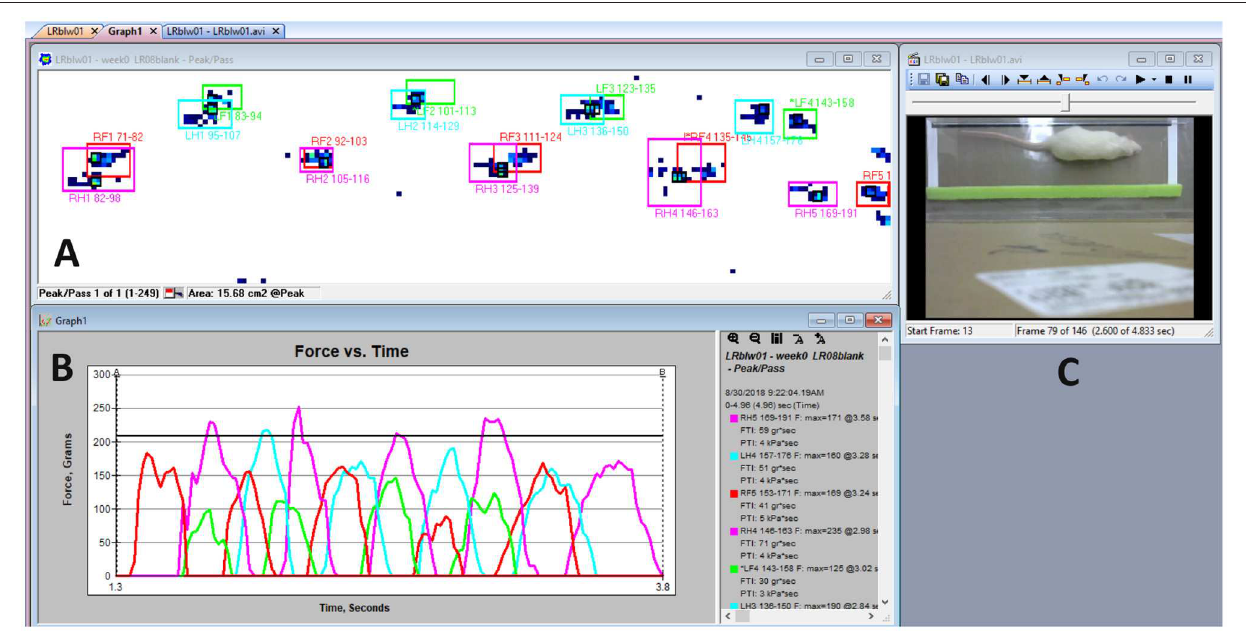
FIGURE 2 | Tekscan software display. (A) Example gait force profile during the subjects walk from right to left. Visual display of right forelimb (red), left forelimb (green), right hindlimb (pink), and left hindlimb (blue) contact sensor boxes is represented as the summation of sensors activated and their corresponding limb recording locations on the mat, time, and gait variables. (B) Graph of force vs. time for the example gait profile of force peaks with their respective limbs. (C) Logitech camera visual output.